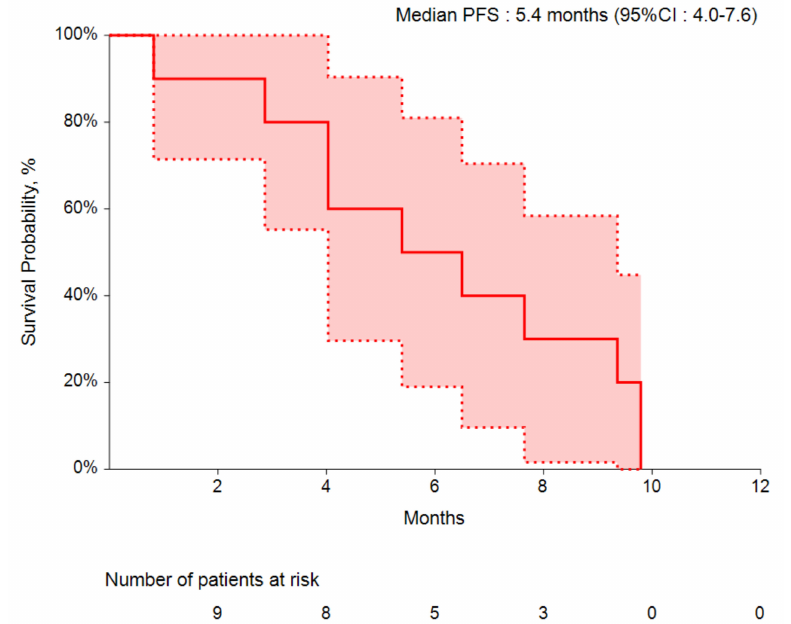
Figure 1. Median progression-free survival (PFS) of patients with IBD-related colorectal cancer treated with chemotherapy and bevacizumab in first line. The area shaded in red represents the 95% confidence interval